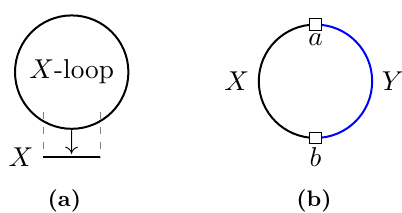
Figure 1. (a): a loop-like topological defect looks like a string locally; (b): two different string-like topological defects ( X, Y ) and 0d domain walls ( a, b ) between them constitute a loop-like topological